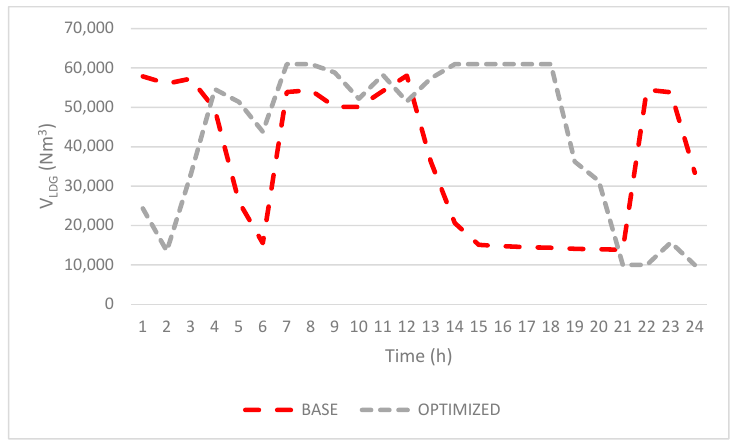
Figure 11. Base and optimized V LDG in the gas holder.